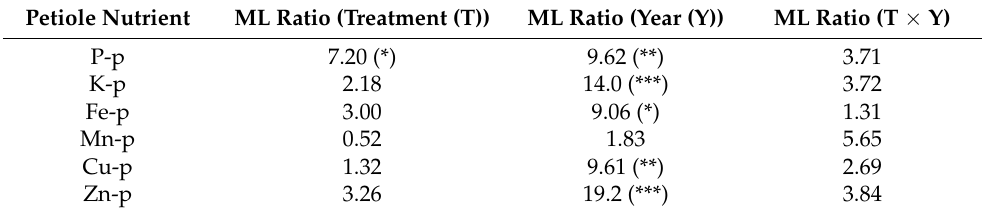
Figure 6. Mean values of the petiole nutrient contents of iron (Fe ‐ p), manganese (Mn ‐ p), copper (Cu ‐ p) and zinc (Zn ‐ p) for each treatment. Treatments: control (C), control of leonardite (CL), and leonardite mixed with ferrous sulphate heptahydrate (LS). Error bars reflect the SE of the mean ( ± 1 SE mean). Table 3. Analysis of variance (ML: Maximum likelihood) performed on petiole nutrient contents at the veraison stage. The results were significant at * p < 0.05, ** p < 0.01 and *** p < 0.001. Petiole Nutrient